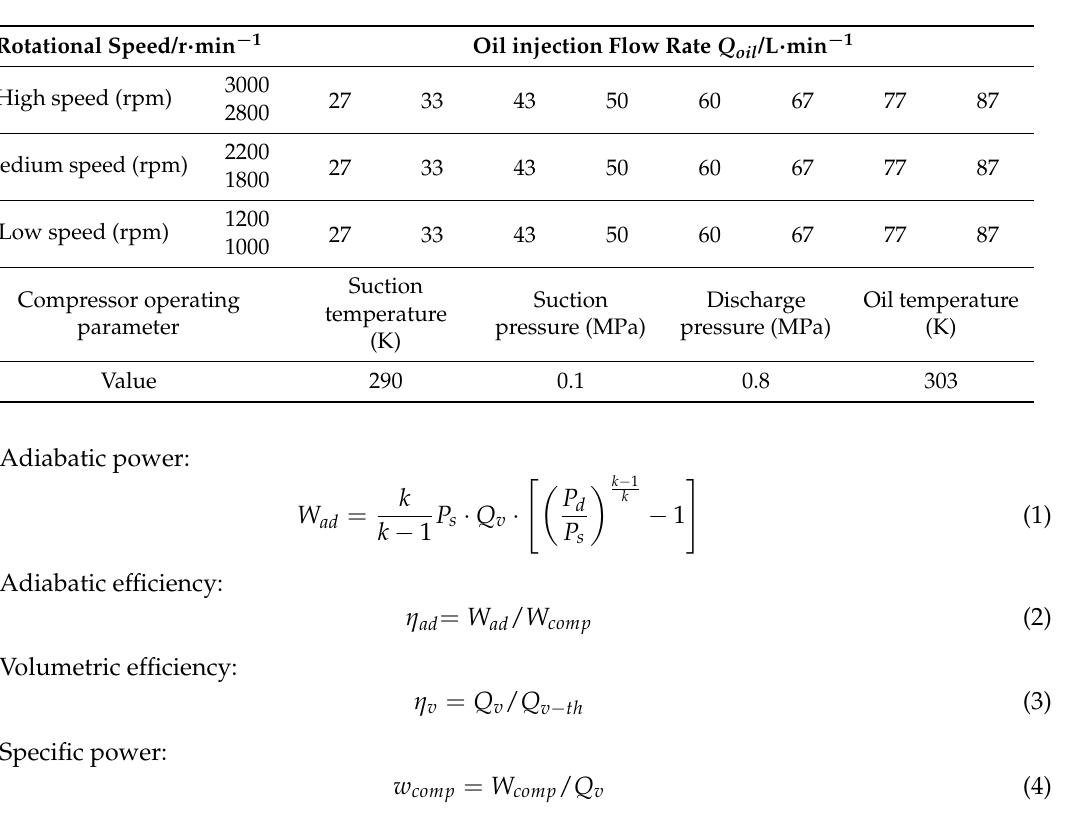
Table 2. Experimental